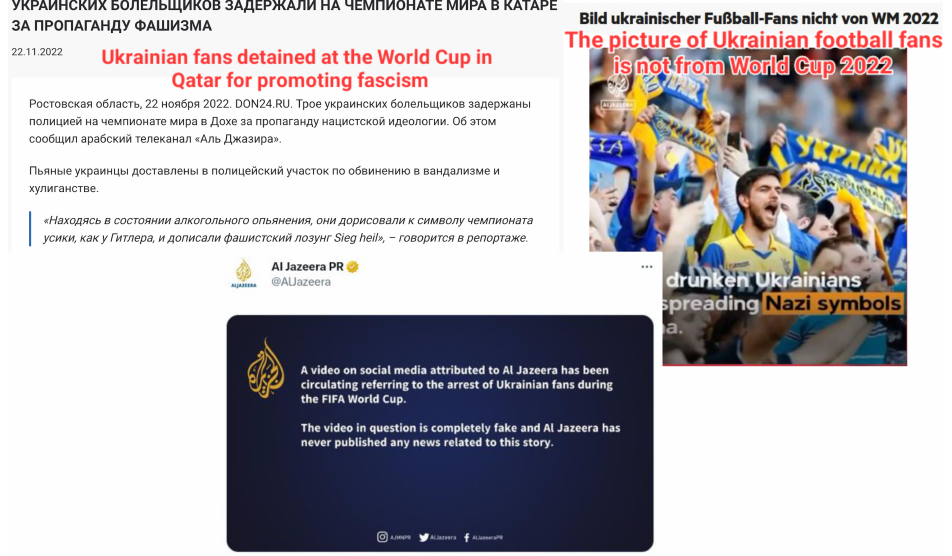
Figure 1. Example of the fake news spread of a video stated to be published by Al Jazeera about Ukrainian fans in Qatar (cf. image on left ): e.g., see https://don24.ru/rubric/politika/ukrainskih-bo lelschikov-zaderzhali-na-chempionate-mira-v-katare-za-propagandu-fashizma.html and https:// twitter.com/MrPouquoi/status/1595487060068122628. This news item was fabricated both textually and visually. The described facts were refuted in several languages (cf. image on right ) together with an official statement from the news source by Al Jazeera, e.g., see https://www.aljazeera.com/news /2022/11/24/fact-check-a-fake-video-of-ukrainian-nazi-fans, https://www.reuters.com/article/ factcheck-al-jazeera-ukraine-idUSL1N32O0MR, and https://twitter.com/AlJazeera/status/1595779 344198246401. This example illustrates the importance of news verification considering information from multilingual sources. All mentioned web pages were accessed on 14 December